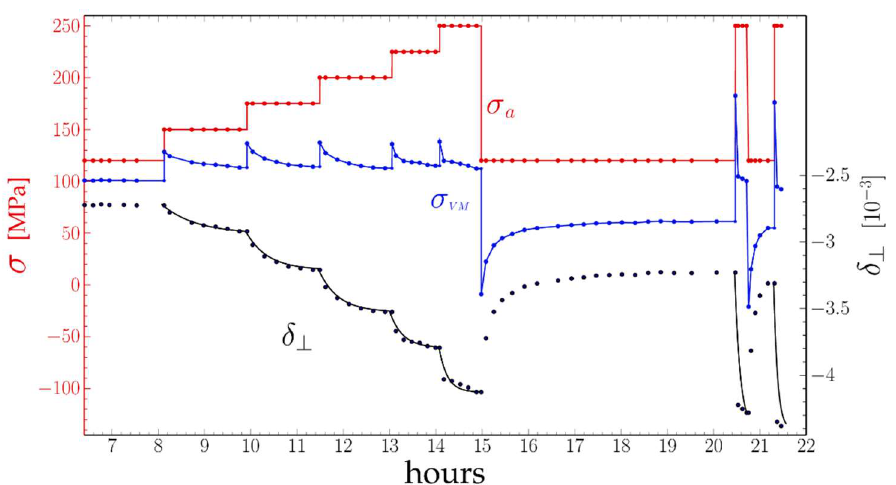
Figure 7. Creep test of a “standard” sample at 1000 ◦ C: applied stress σ a (red), calculated σ VM (blue) and in black, δ ⊥ measured (points) and calculated (lines) for an exponential decay of δ ⊥ for the different decay times given in Table 1.